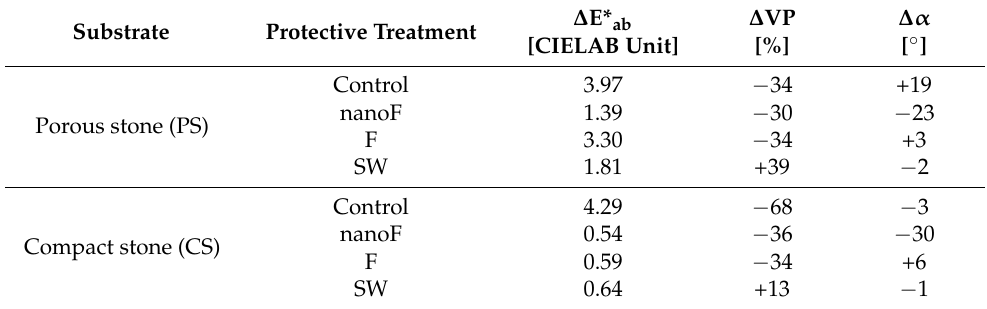
Table 2. Effects of the pancreatin test: color difference ( ∆ E* ab ), changes in vapor permeability ( ∆ VP),